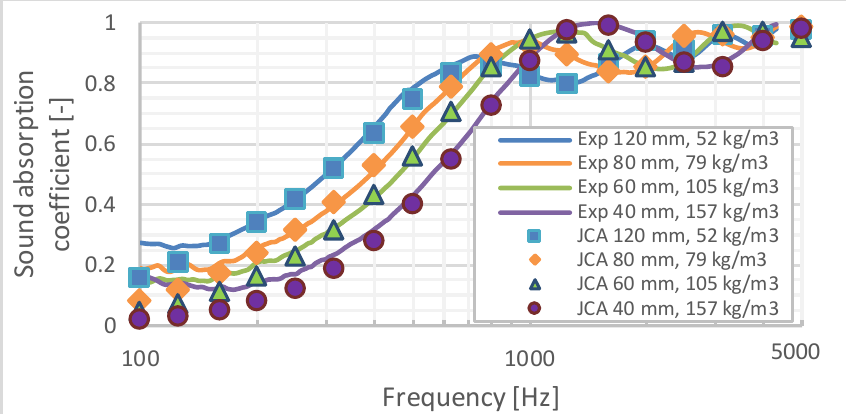
Figure 7. Comparison between the experimental measurements (Exp) and analytical model (JCA) for four different combinations of thickness and density (constant sample weight).